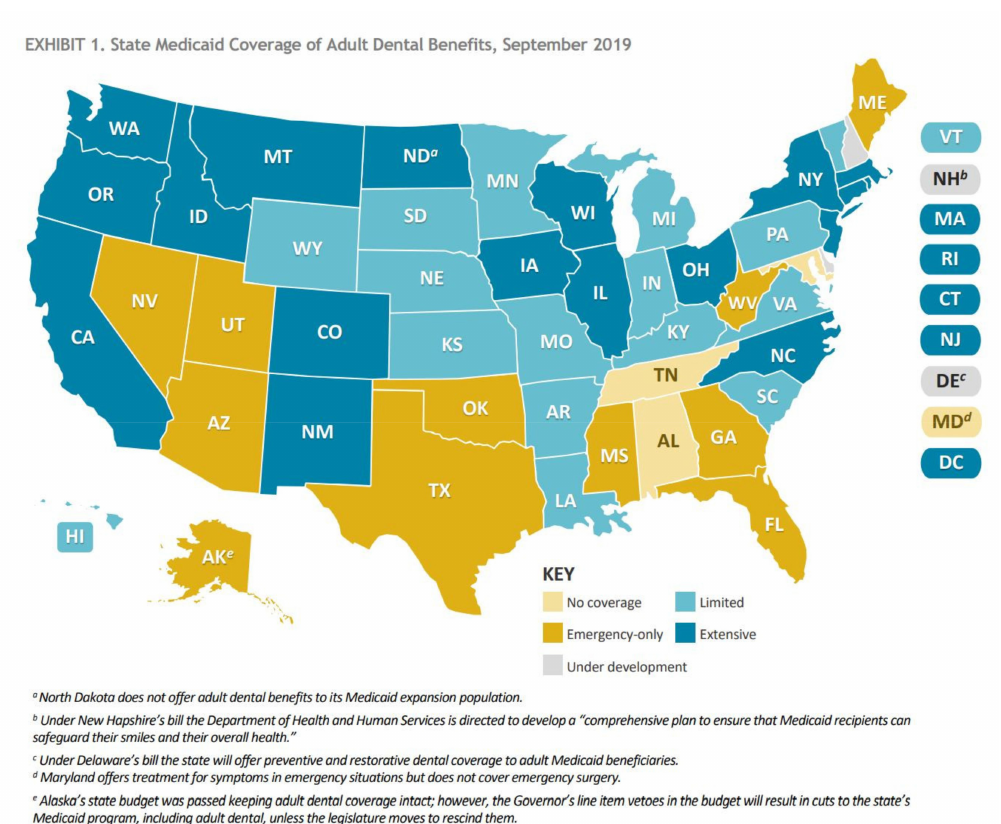
Figure 2. States Medicaid coverage for dental benefits